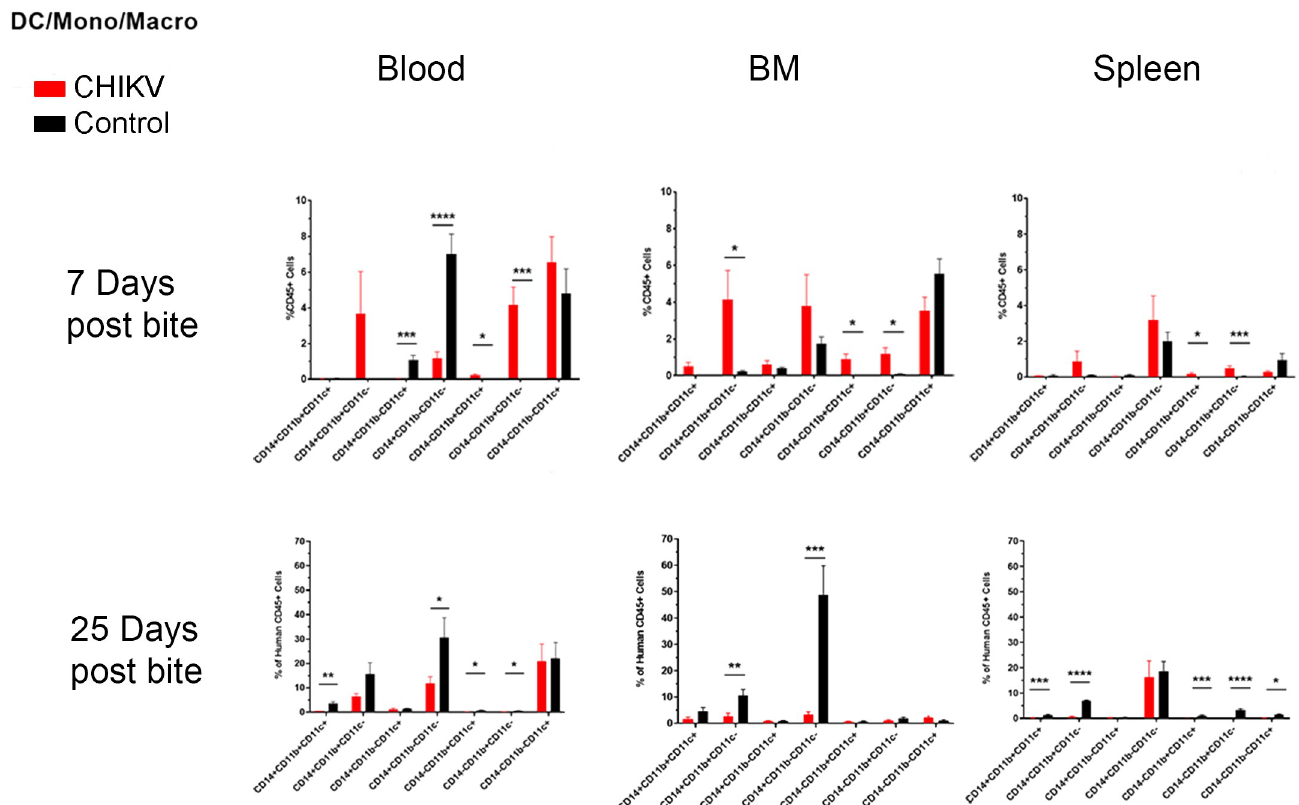
Fig 6. Summary of significant flow cytometry results (dendritic cells, monocytes, and macrophages) comparing Hu-NSG mice bitten by infected mosquitoes versus those bitten with control (uninfected) mosquitoes. Hu-NSG mice were infected with CHIKV via mosquito bite. At 7 and 25 days post-infection, mice were euthanized, and changes in immune cell populations in the blood, spleen, and bone marrow between infected and control mice were assessed via flow cytometry. Outliers were removed via ROUT analysis, and statistical significance was assessed via multiple comparison t-test using the Holm-Sidak correction. Immune components are outlined in the graphs above and summarized in table 5. Asterisks indicate significance differences (n.s. = not significant; � p < 0.05; �� p < 0.01; ��� p < 0.005).